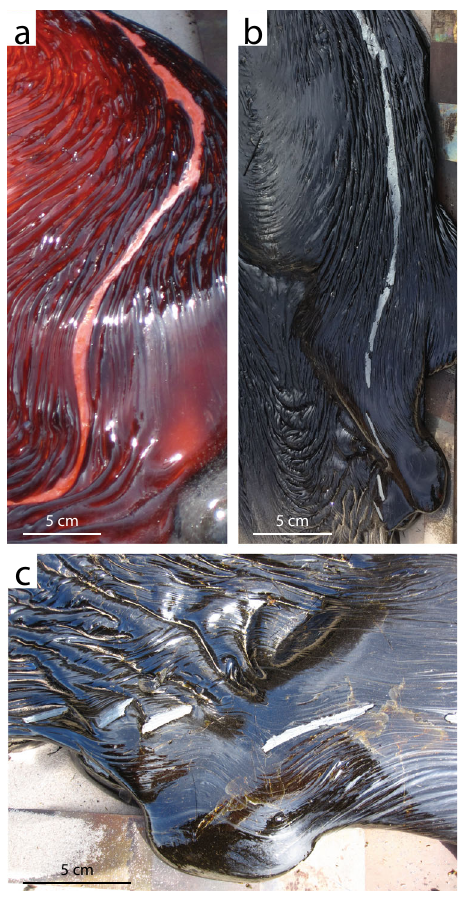
Fig. 4 Sur fi cial metallic fl ow morphology. a A small metallic fl ow (bright orange) on top of the silicate fl ow (dark orange), following the topography of the ropey silicate fl ow surface texture. b The aspect of the metallic fl ow (silver) in a after cooling. c Close up of b : note how the metallic ribbon is dismembered en échelon downstream.